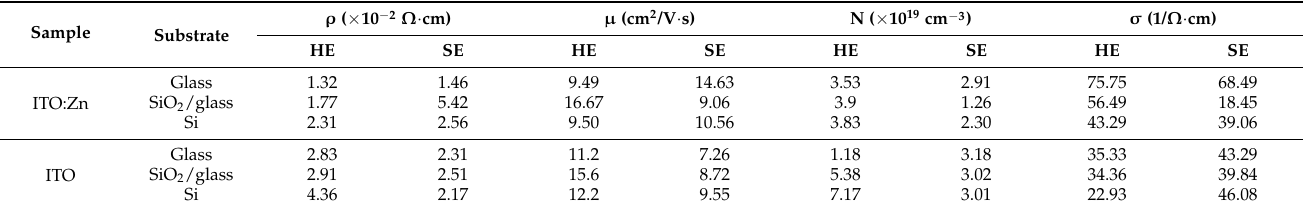
Table 3. Comparison of the electrical parameters obtained through SE data modeling and HE measurements.